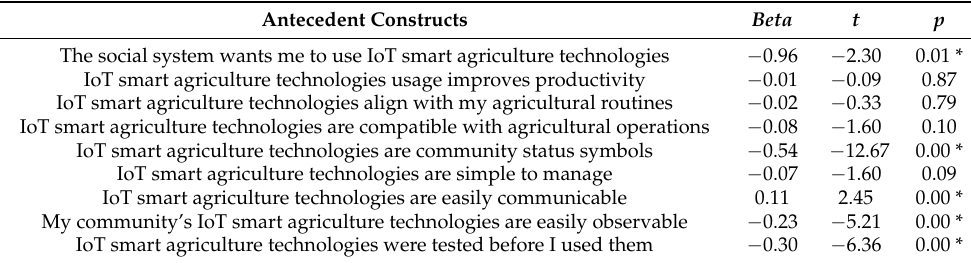
Table 10. IoT Smart Agriculture Adoption Constructs. Antecedent Constructs